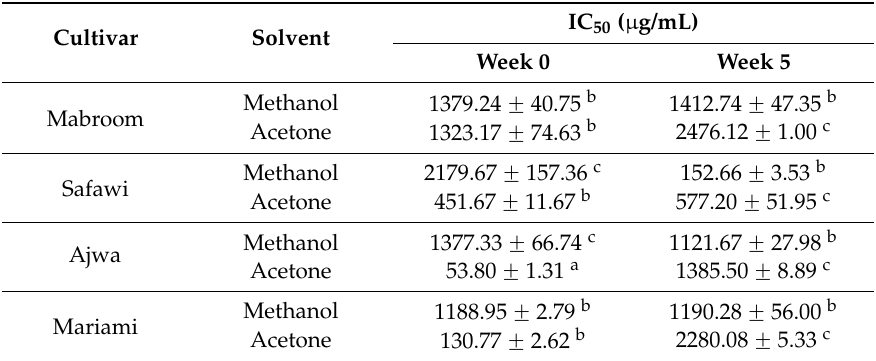
Table 3. Effect of chilled fruits extract storage at ´ 20 ˝ C on IC 50 ( µ g/mL) of different P. dactylifera extracted using different